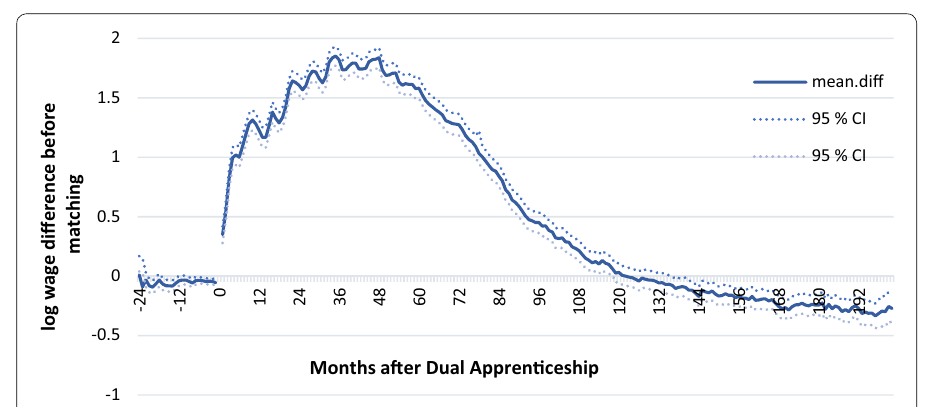
Fig. 5 Earnings differences between vocationally and academically educated people after completed apprenticeship (2213 foremen and 17,062 academics)